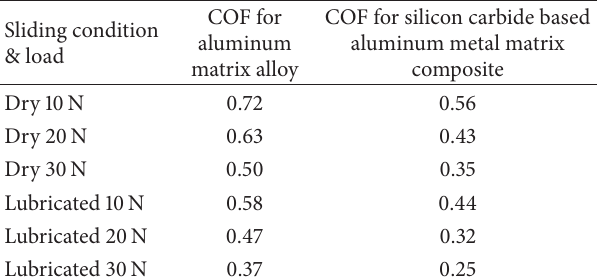
Table 4: Variation of coefficient of friction with load for aluminum matrix alloy and silicon carbide based aluminum metal matrix composite at 𝑉 = 3.77 m/sec.